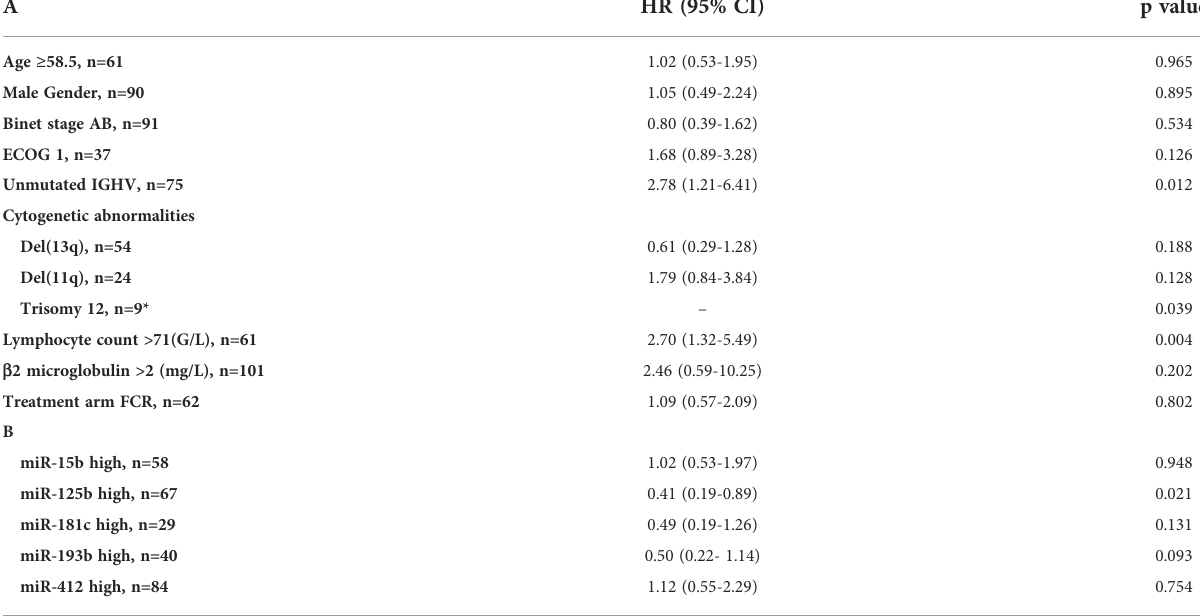
TABLE 5 Univariate analysis of PFS according to baseline characteristics and